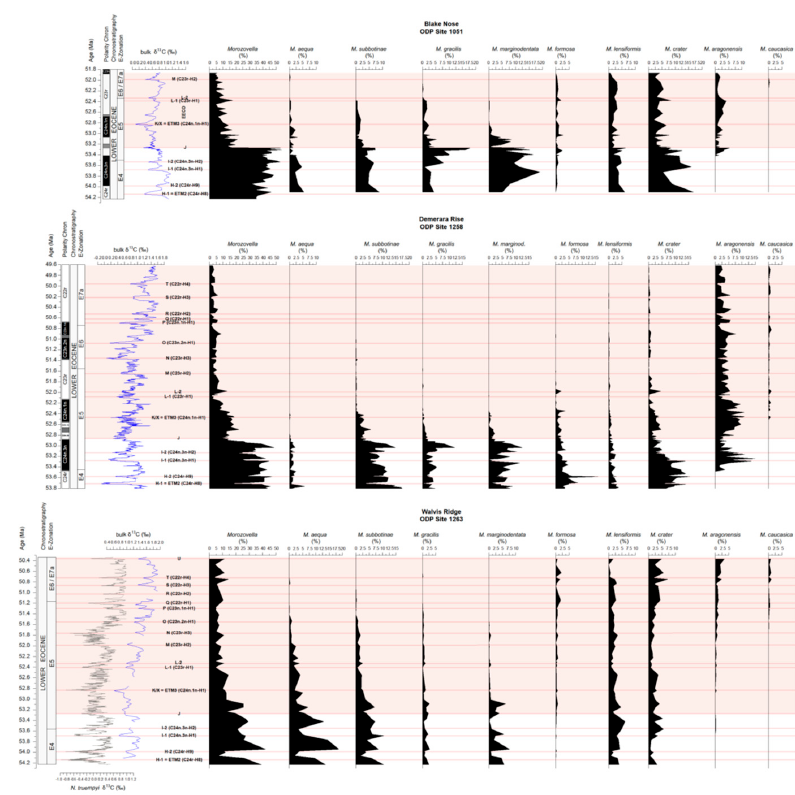
Figure 5. Records of stable carbon isotopes ( δ 13 C) and Morozovella species relative abundance against Age (Ma) from the Atlantic ODP Sites 1051, 1258 and 1263. Bulk sediment δ 13 C from Site 1051 is from [41]. The bulk sediment δ 13 C record from Site 1263 is from [42] (blue) while the benthic foraminiferal ( N. truempyi ) δ 13 C record comes from [19] (grey). Note that the morozovellid species abundance varies across the sites differently contributing to the permanent decline in abundance of the genus Morozovella.